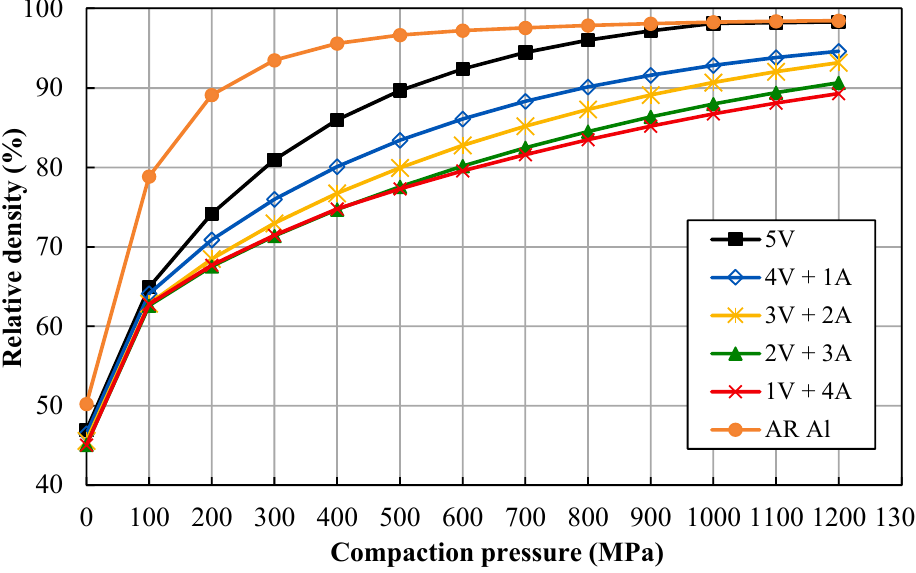
Figure 1. Compressibility curves of the different milled powders.